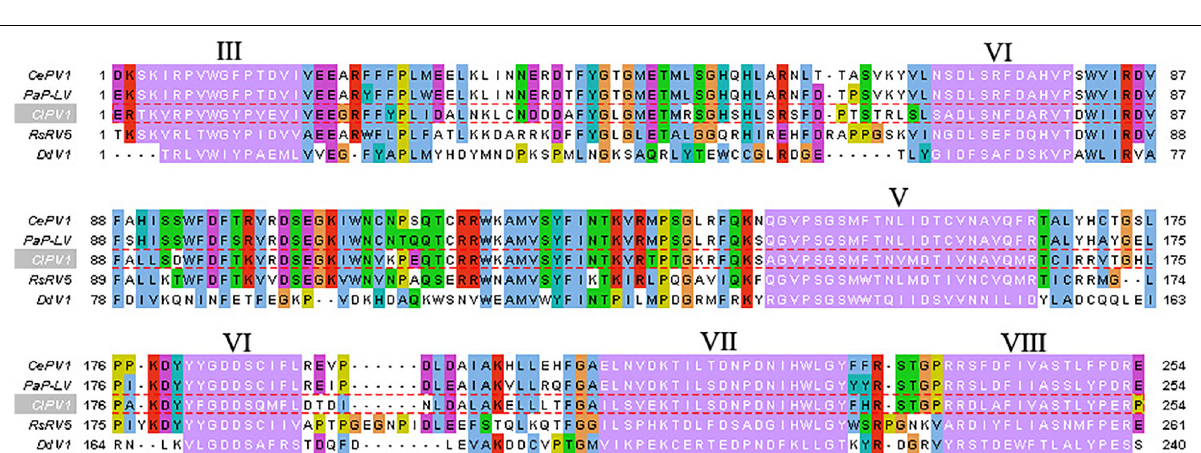
particles and a PEG-mediated protoplast transfection